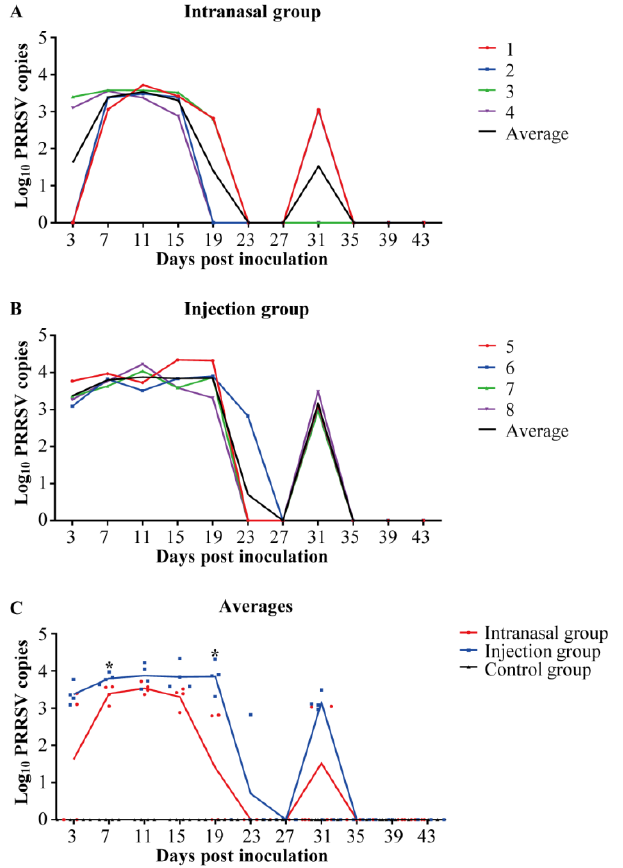
Figure 1. Viremia of PRRSV-inoculated piglets. Viral loads were quantified in serum through RT- qPCR in piglets to assess the viremia of PRRSV. Twelve 20-days-old healthy piglets were divided into three groups ( n = 4 in each group). Piglets in the test groups were inoculated with attenuated PRRSV (10 6 TCID 50 ) through intranasal and intramuscular inoculation respectively, and piglets in the control group were inoculated with equal volumes of the cell culture medium. Serum samples were collected at 0, 3, 7, 11, 15, 19, 23, 27, 31, 35, 39 and 43 dpi. Piglets in the control group were PRRSV-negative throughout the study. A and B: Colored lines represent individual animals, and black lines represent the mean value for each group. Numbers (1–8) represent the individual pig numbers. ( A ) Viremia of piglets in the intranasal group. ( B ) Viremia of piglets in the injection group. ( C ) The averages of viremia in each group. Statistical differences were determined using the t -test (* p < 0.05). Comparisons were undergone between the Intranasal and the Injection groups.